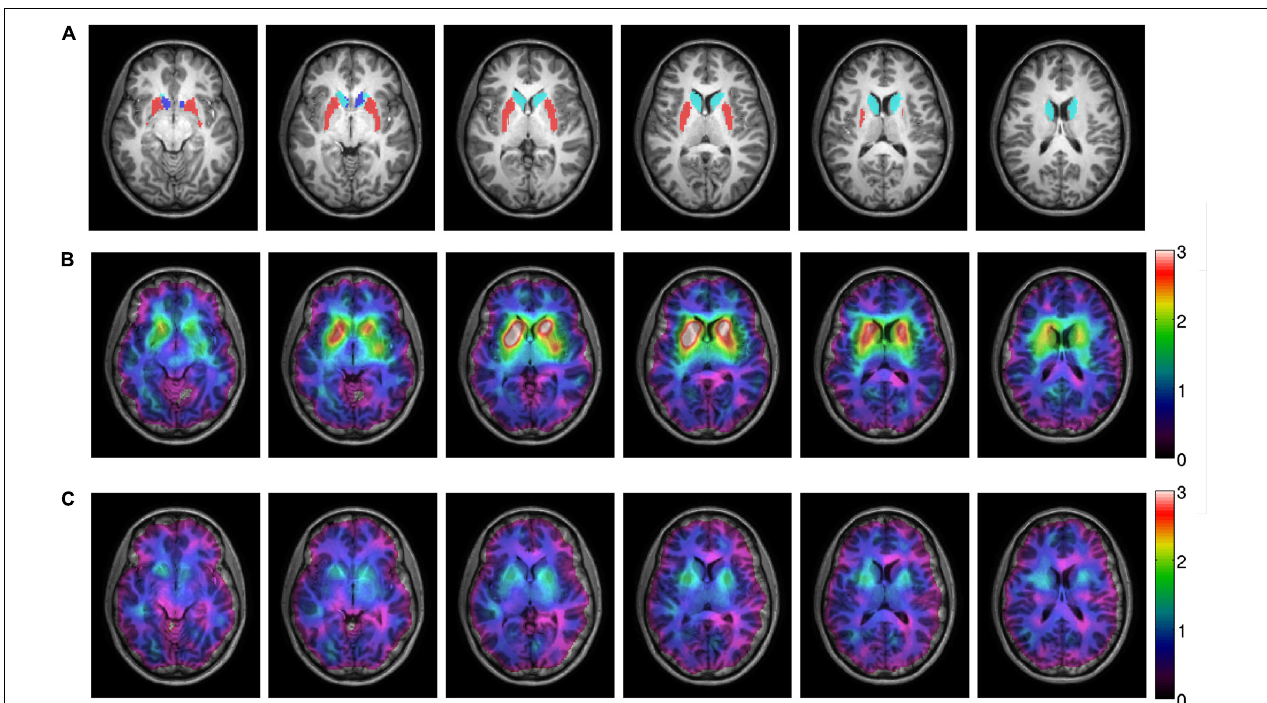
FIGURE 1 | MRI and SPECT images of one patient, treated with 300 mg amisulpride displaying a mean dopamine D 2 receptor occupancy of 56%. Panel (A) shows the sMRI image with the caudate nucleus (light blue), putamen (red) and accumbens (dark blue) from the subcortical Harvard-Oxford atlas depicted. Panels (B,C) show the co-registered SPECT image on top of the MRI image. The color scale corresponds to the specific binding potential before treatment (B) and after six weeks of treatment (C)